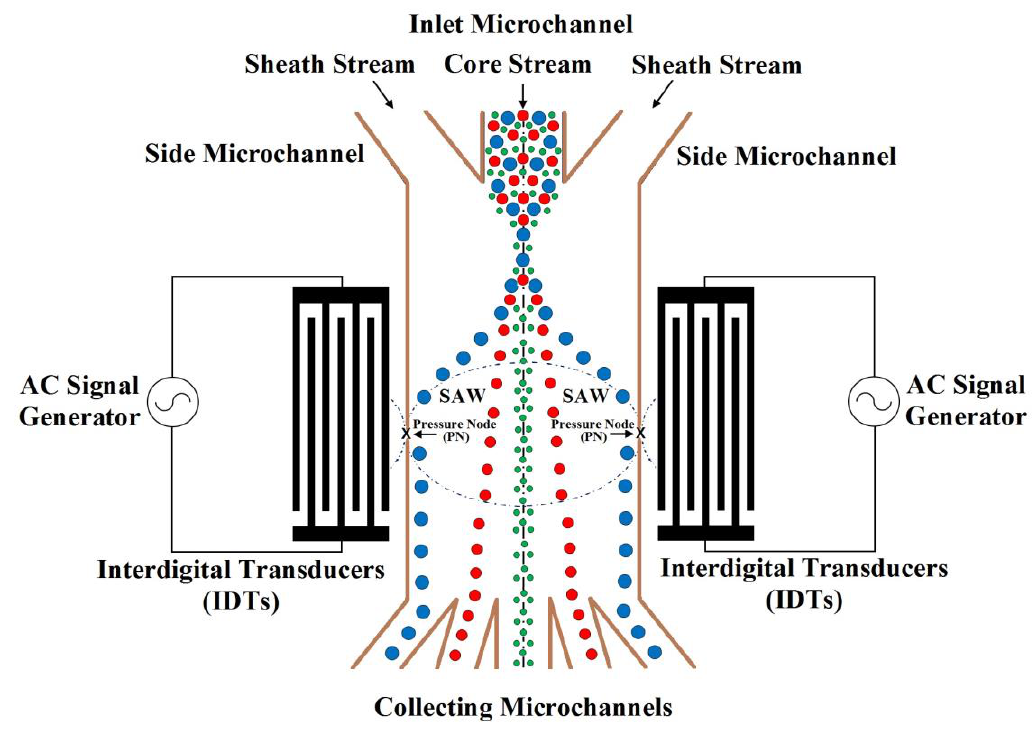
Figure 1. The schematic of SSAW microfluidic device for particles separation. (The figure is not to scale.)